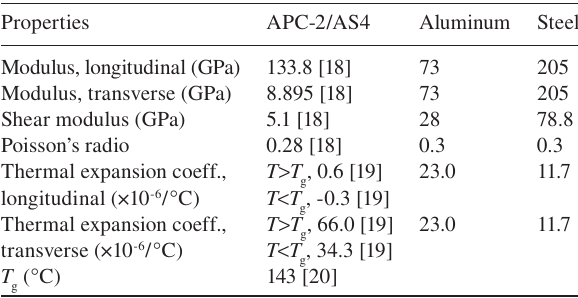
Table 5 Input parameters for thermal stress analysis.